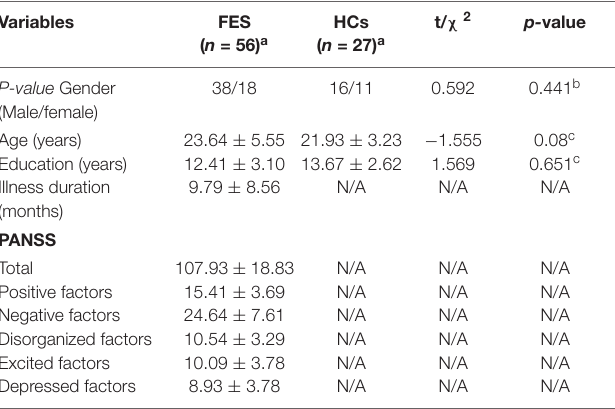
TABLE 1 | Demographic data and clinical information in patients with FES and health controls.